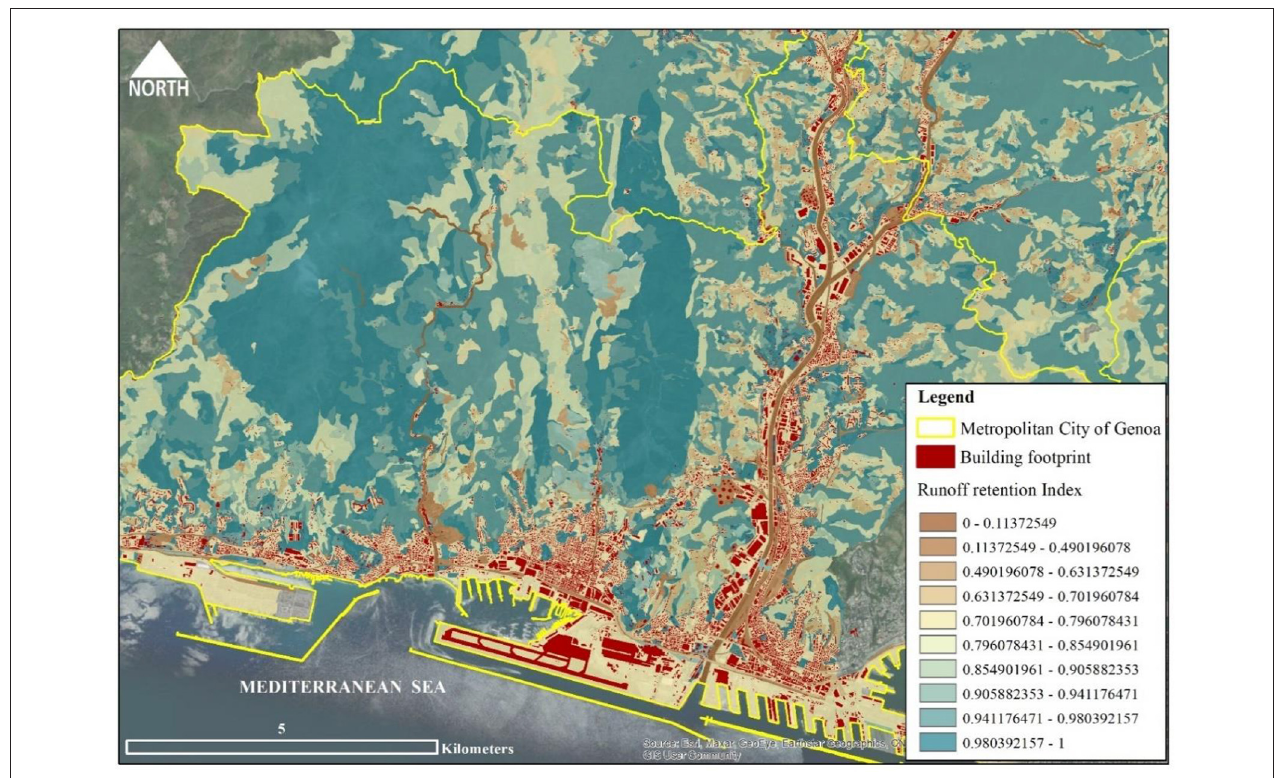
FIGURE 5 | Runoff retention Index per pixels (50mm of rainfall) for the Municipality of Genoa (source: authors).